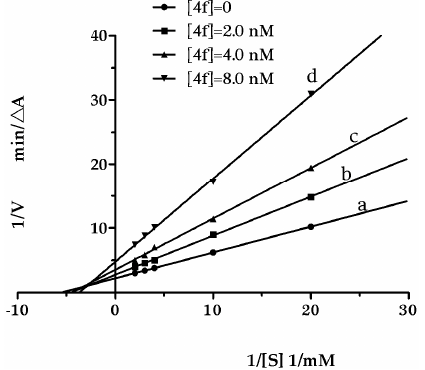
Figure 1. Lineweaver-Burk plot for the inhibition of AChE by 4f .